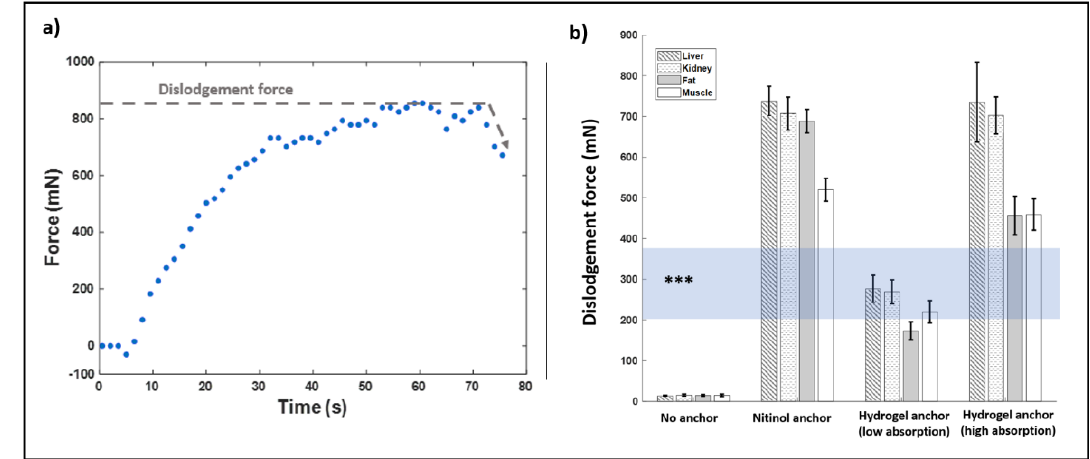
Figure 5. ( a ) Example force vs. time curve, obtained from nitinol-anchored microdevice in phantom model (mN = millinewtons, s = seconds). Microdevice dislodgement typically correlated with a sharp decrease in measured force (dotted line). The maximum force prior to this decline was recorded as the dislodgement force. ( b ) Dislodgement forces compared among anchoring methods and tissue types. The shaded horizontal region (***) corresponds to force ranges required for minimally invasive retrieval of the IMDs, as previously described [14].